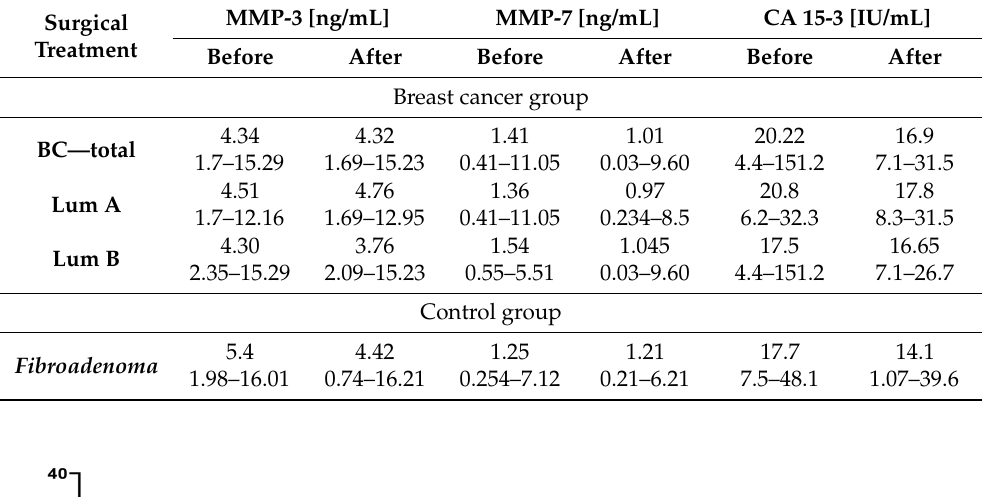
Table 2. Plasma concentrations (median and minimum-maximum range) of studied parameters: MMP-3, MMP-7 and comparative marker CA 15-3 in BC patients, fibroadenoma subjects and healthy women. Table 3. Plasma levels (median and minimum–maximum range) prior to and post surgical treatment of MMP-3, MMP-7 and comparative marker CA 15-3 for matched pairs of BC and fibroadenoma patients.